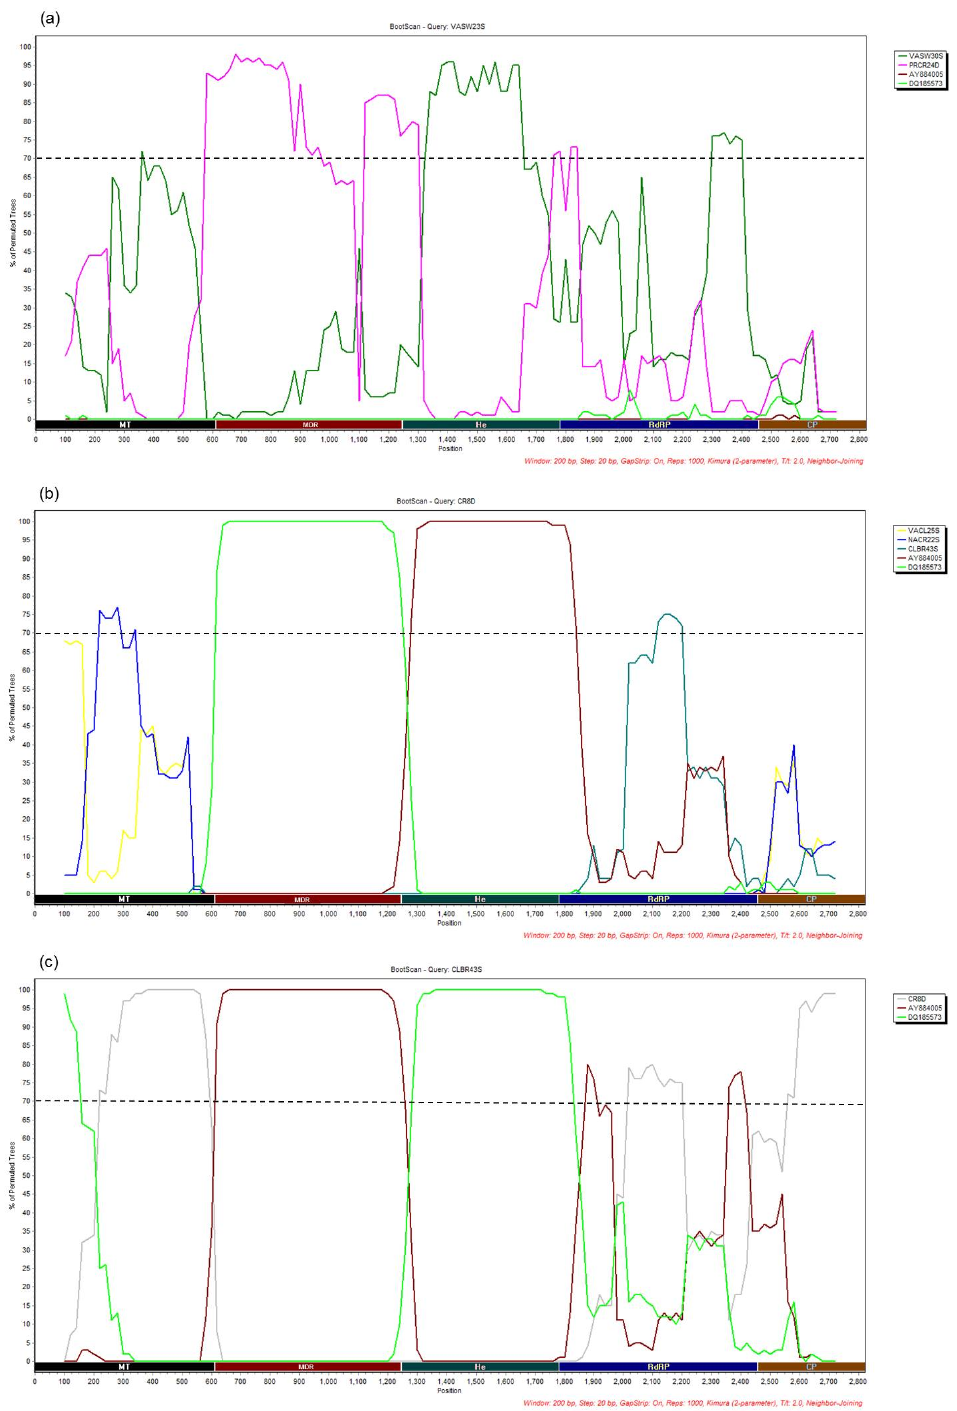
using Simplot. Three CSDaV isolates, VASW23S ( a ), CR8D ( b ) and CLBR43S ( c ), were used as query sequences and two CSDaV isolates were used as reference sequences. The Y ‐ axis illustrates variation in identity percentage. Analyses were done using a sliding window of 200 bp and a step size of 20 bp. Red vertical dashed line shows the proposed recombination break point. Sequences compared with the query sequence are indicated in the legend.